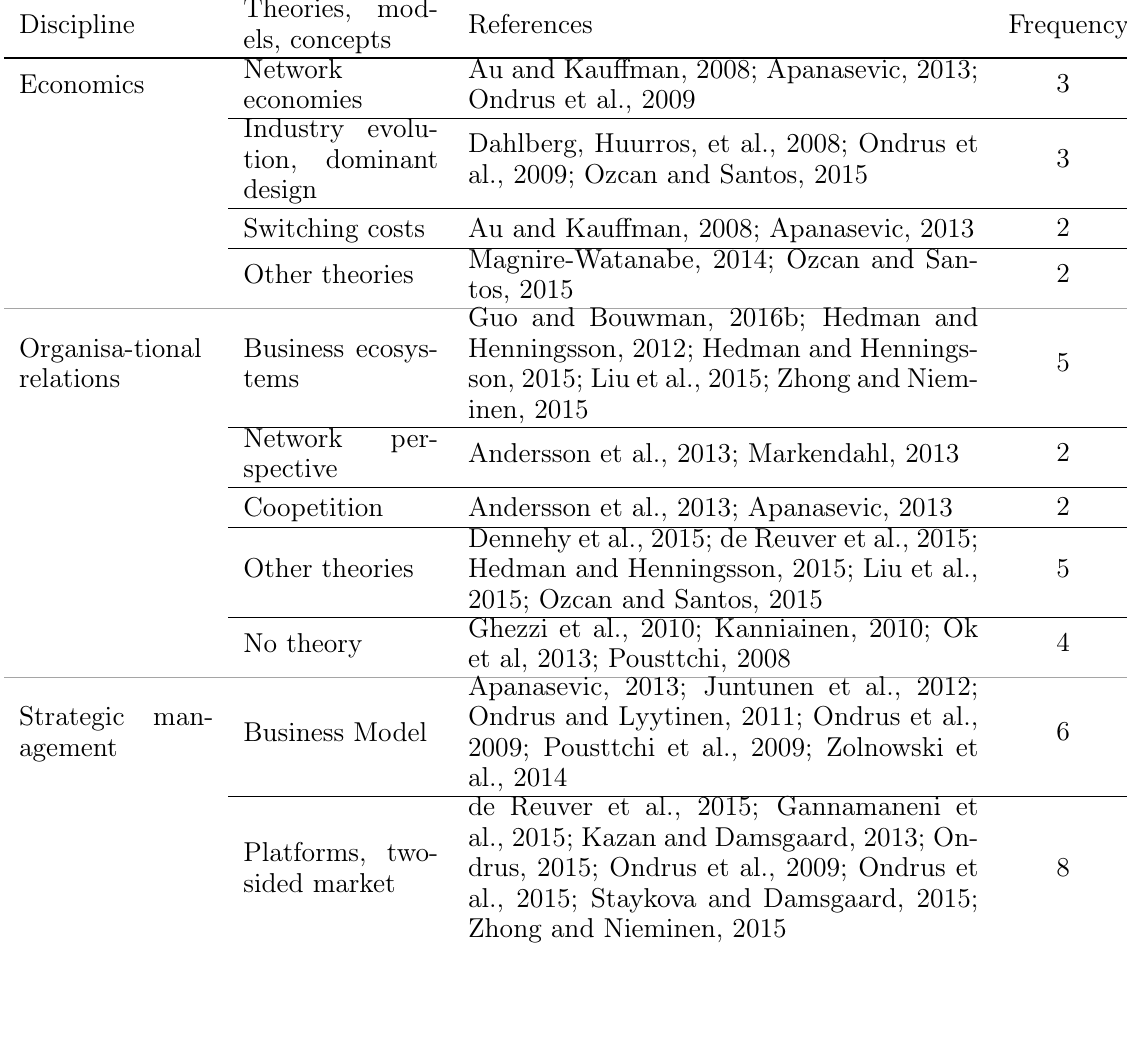
Theoretical perspectives used in research on business aspects of mobile pay-